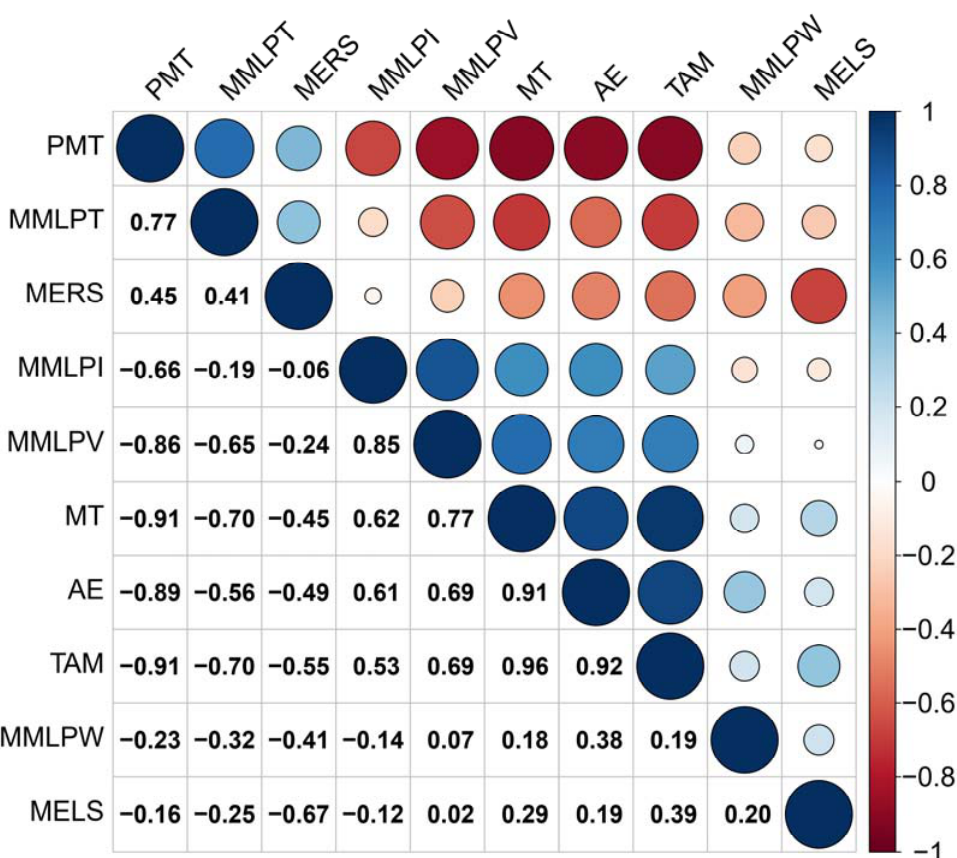
Figure 2. Correlation results for the glutopeak test and mixograph results. PMT = peak maximum time, MT = maximum torque, TAM = torque after maximum, AE = aggregation energy, MELS = mixograph envelope left slope, MERS = mixograph envelope right slope, MMLPT = mixograph MID line peak time, MMLPV = mixograph MID line peak value, MMLPW = mixograph MID line peak width, MMLPI = mixograph MID line peak integral.